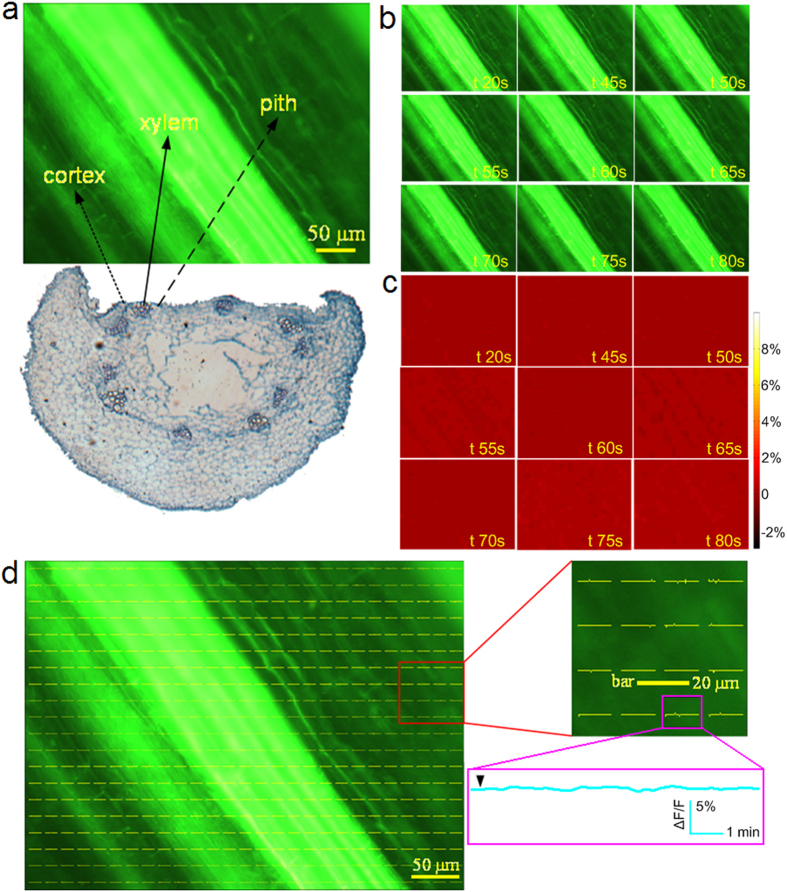
Optical recording of different tissues such as the cortex, xylem and pith.(a) An image of a radial face paraffin section that was made at the end of the experiment showing different tissues such as the cortex, xylem and pith. (b) A series of consecutive raw fluorescence images. (c) Time lapse ∆F/F images. No variation in the fluorescence intensity was observed. (d) The results of the optical recording. There was no ΔF/F change in the cortex, xylem or pith tissues, although the APs were recorded using the Ag/AgCl electrode.